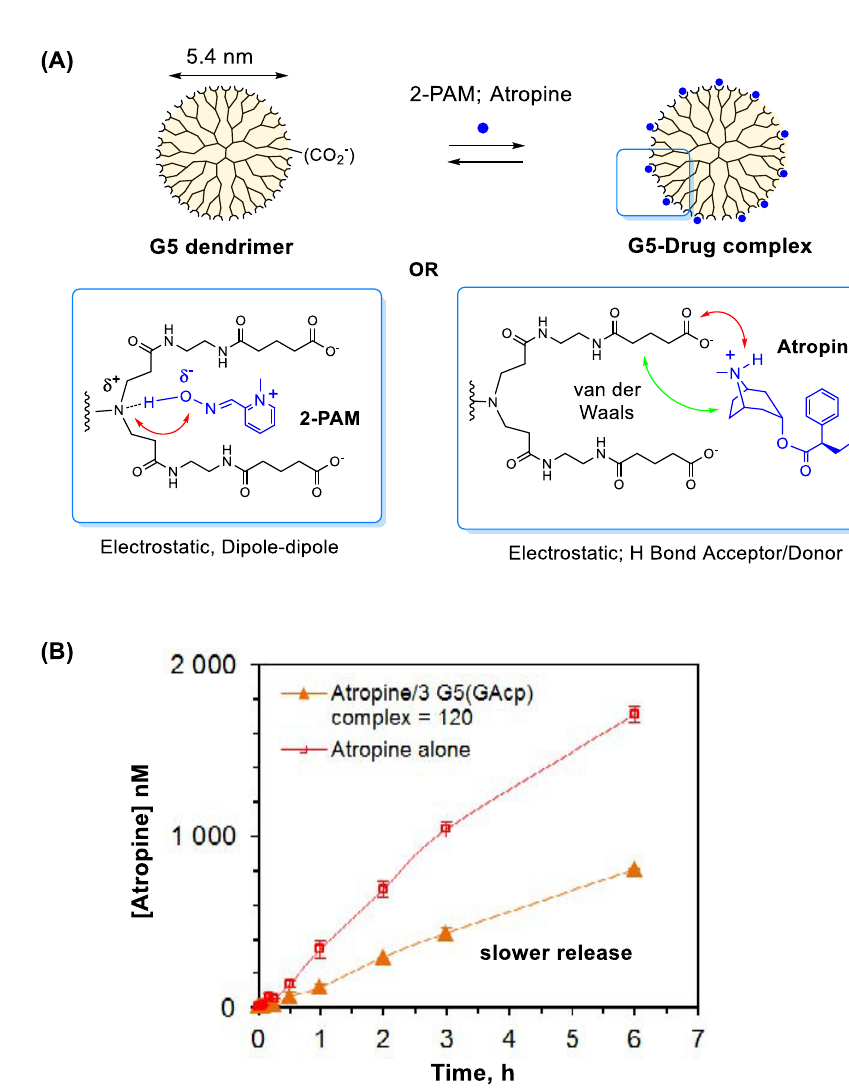
Figure 4. ( A ) A proposed model for 2-PAM or atropine complexation in fifth generation (G5) PAMAM dendrimer [86,89] and ( B ) a drug release kinetics for an atropine-dendrimer complex. G5(GA cp ) refers to a G5 PAMAM dendrimer modified with cyclopentane (cp)-fused glutarate (GA). Reproduced with permission from [89], Copyright 2015, American Chemical Society.